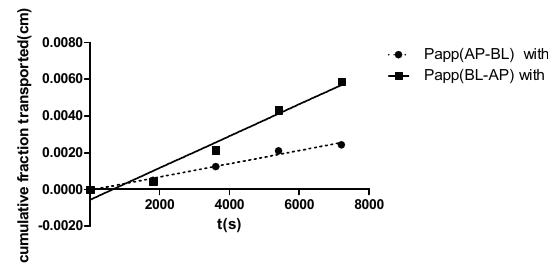
Figure 2. Polarized efflux of R-123 in MDCK-hMDR1 was shown to be inhibited by